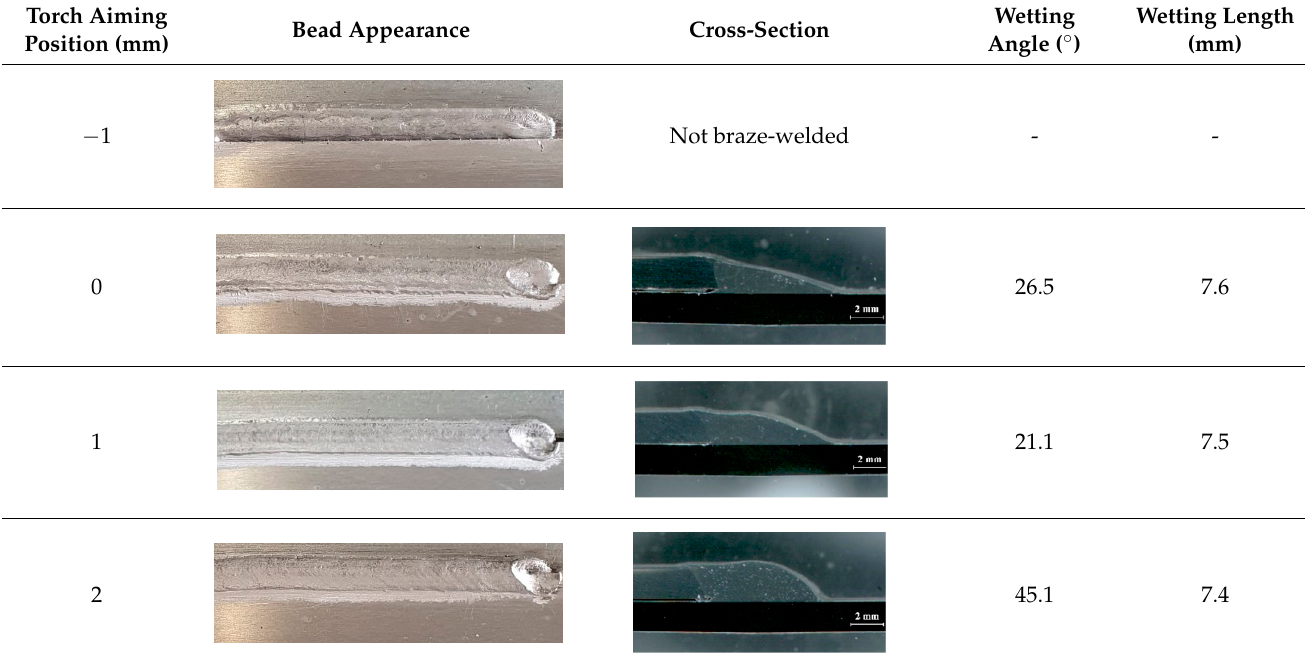
Table 4. Bead appearance and cross-sectional view of braze-welded joints. Torch Aiming Position